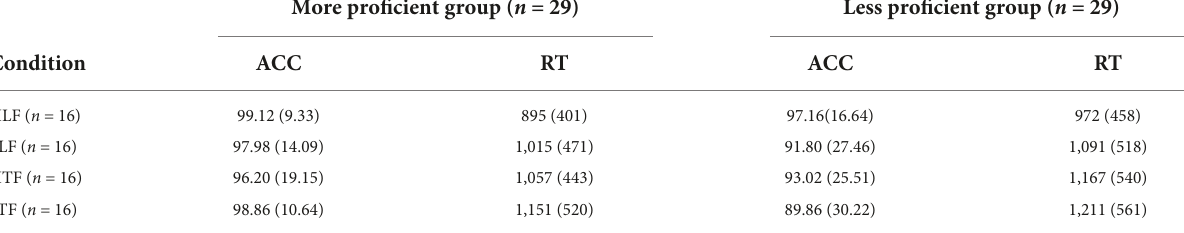
TABLE 4 Mean reaction time (RT, in ms) and accuracy (ACC, in %) of the two proficiency groups in lexical decision